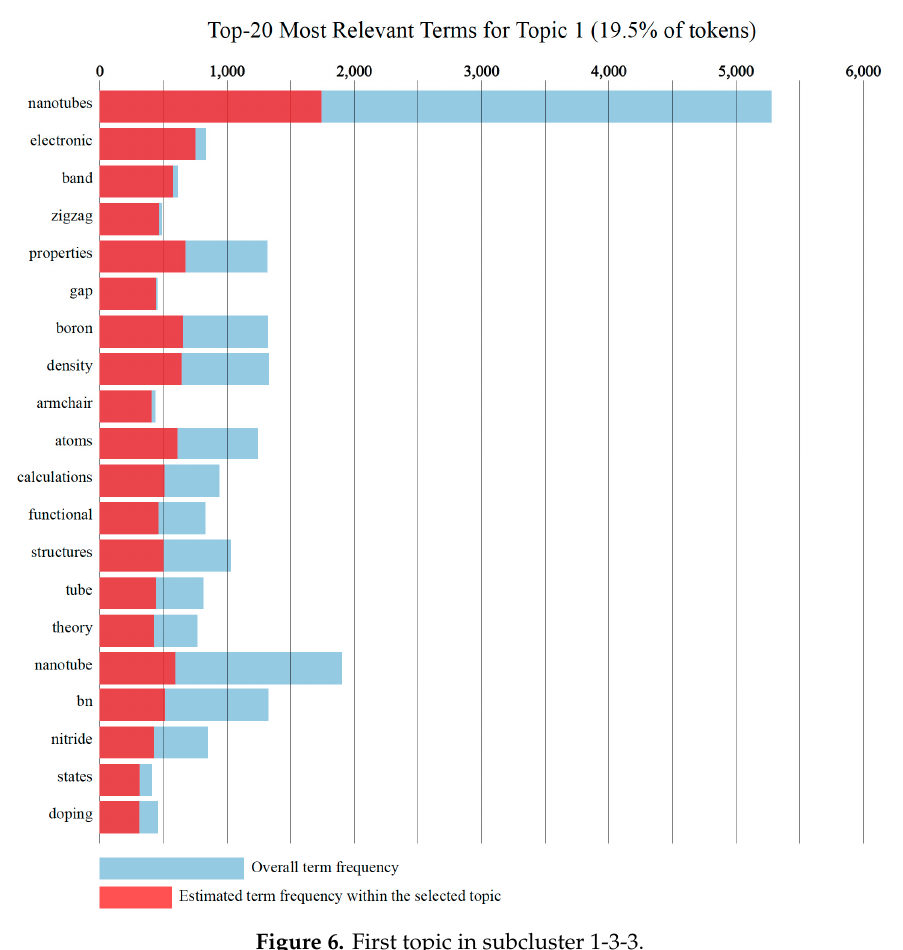
Figure 6. First topic in subcluster 1-3-3.